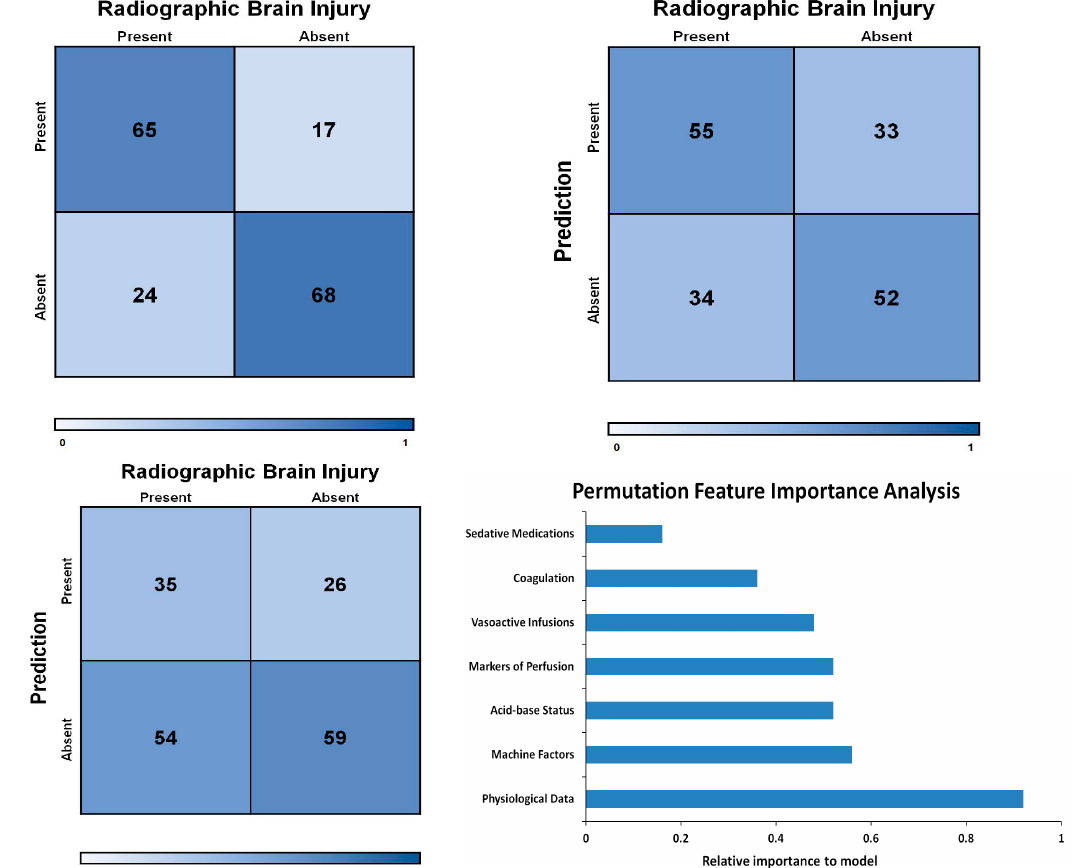
Figure 3. (a) Demonstrates model’s confusion matrix. (b) Demonstrates logistic regression model’s confusion matrix. (c) Matrix based on clinician suspicion for occurrence of injury. (d) Results